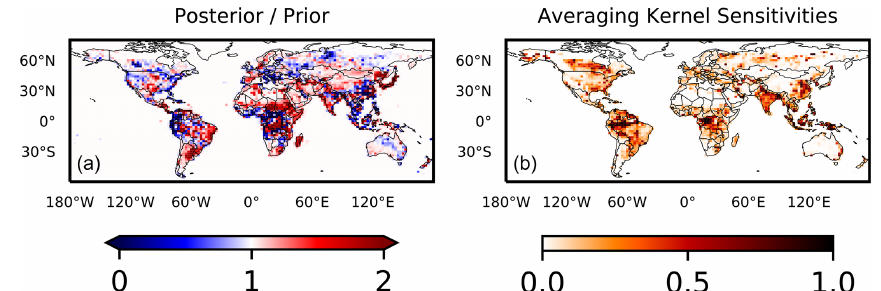
Figure 2. (a) Corrections to prior estimates of methane emissions on the 2 ◦ × 2.5 ◦ grid and corresponding averaging kernel sensitivities. (b) The averaging kernel sensitivities are the diagonal elements of the averaging kernel matrix for the inversion. The trace of the averaging kernel matrix defines the degrees of freedom for signal (DOFS) for the inversion, shown in the